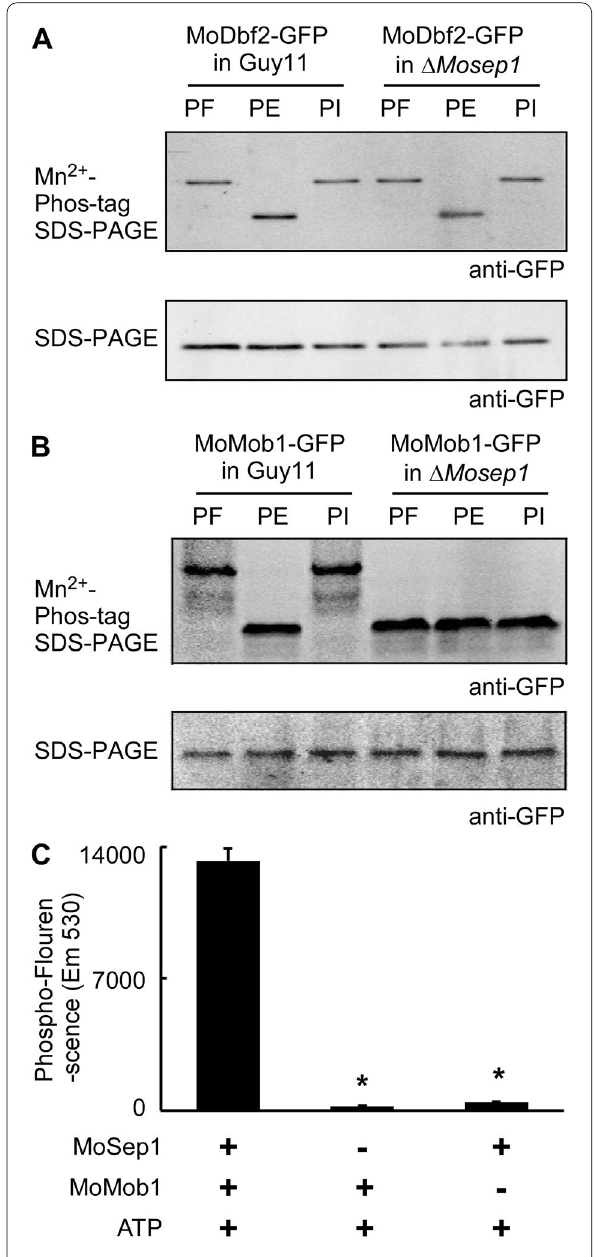
Fig. 2 MoSep1 phosphorylates MoMob1. A In vivo phosphorylation analysis of MoMob1 in the Guy11 and the Δ Mosep1 mutant strain. MoMob1-GFP proteins treated with phenylmethylsulfonyl f﻿luorid (PF), phosphatase (PE) and phosphatase inhibitors (PI), and detected by the anti-GFP antibody. The phosphorylated-MoMob1 band is higher than controls when detected in the Mn 2 + -Phos-tag SDS-PAGE gel. B In vivo phosphorylation analysis of MoMob1 in the Guy11 and the Δ Mosep1 mutant strains. MoMob1-GFP proteins treated with phenylmethylsulfonyl f﻿luorid (PF), phosphatase (PE) and phosphatase inhibitors (PI), and detected by the anti-GFP antibody. The phosphorylated-MoMob1 band is higher than controls when detected in the Mn 2 + -Phos-tag SDS-PAGE gel. C In vitro phosphorylation analysis by the f﻿luorescence detection in tube (FDIT) method. Purified proteins of His-MoMob1 and His-MoSep1 were used for kinase reactions in the presence of 50 μm ATP and then dyed with the Pro-Q Diamond Phosphorylation Gel Stain. The f﻿luorescence signal at 590 nm (excited at 530 nm) was measured in a Cytation3 microplate reader (Biotek, Winooski, VT, USA). Error bars represent the standard deviations from three independent experiments. Asterisks indicate statistical significance according to a Student’s test ( p <